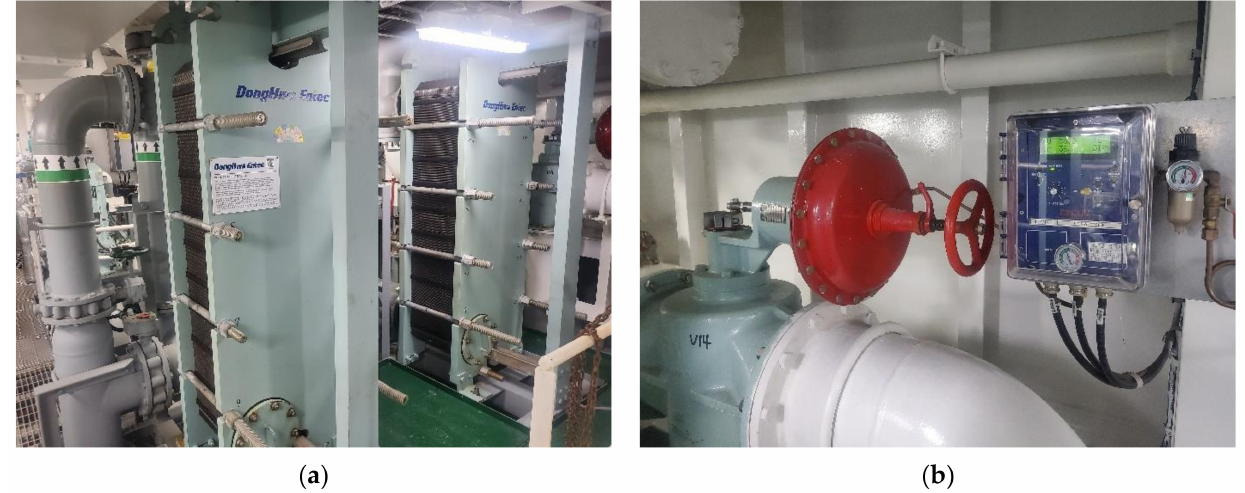
Figure 3. ( a ) Central heat exchangers (2 units in total); ( b ) 3-way valve and